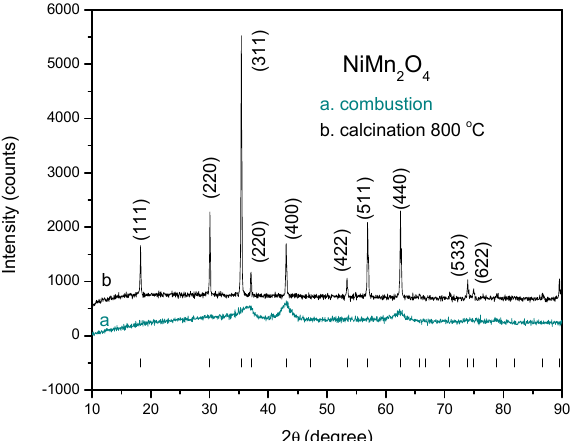
Figure 2. X-ray diffraction patterns of NiMn 2 O 4 powder after combustion ( a ) and calcination ( b ), peaks marked according to JCPDS card 71-0852.